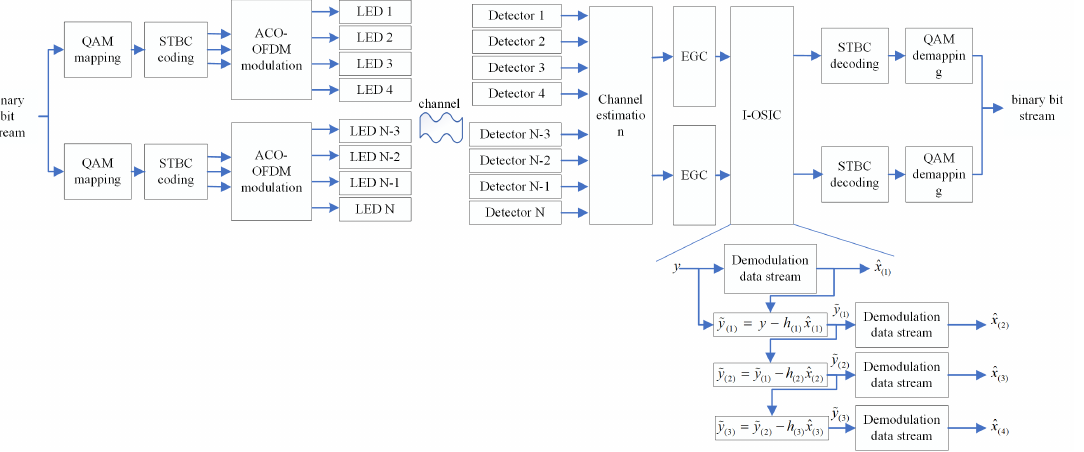
Figure 2. MIMO ACO-OFDM STBC system block